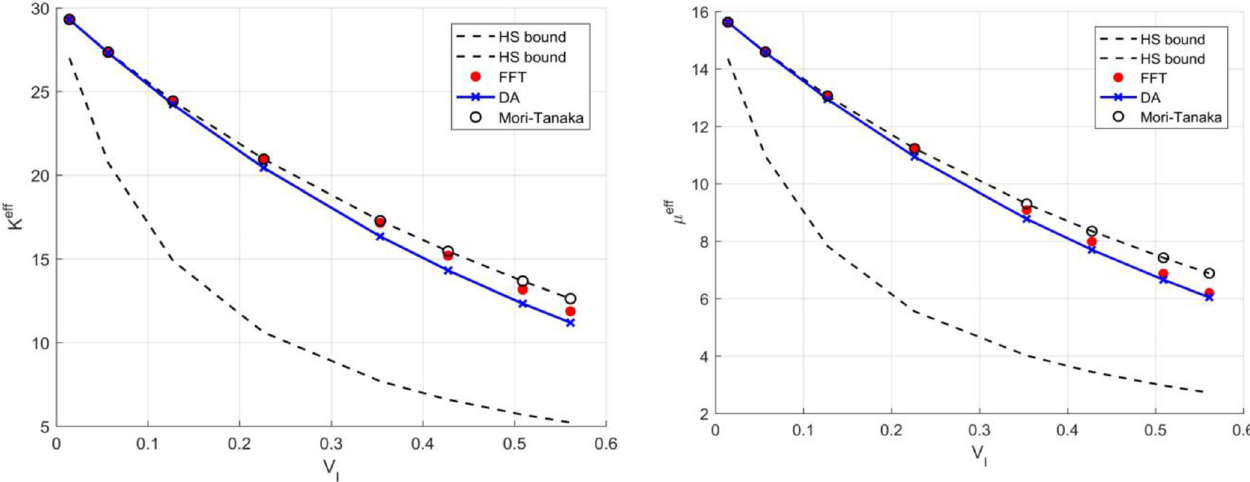
Fig. 3. Elastic bulk (left) and shear modulus (right) of three-phase composites with the case